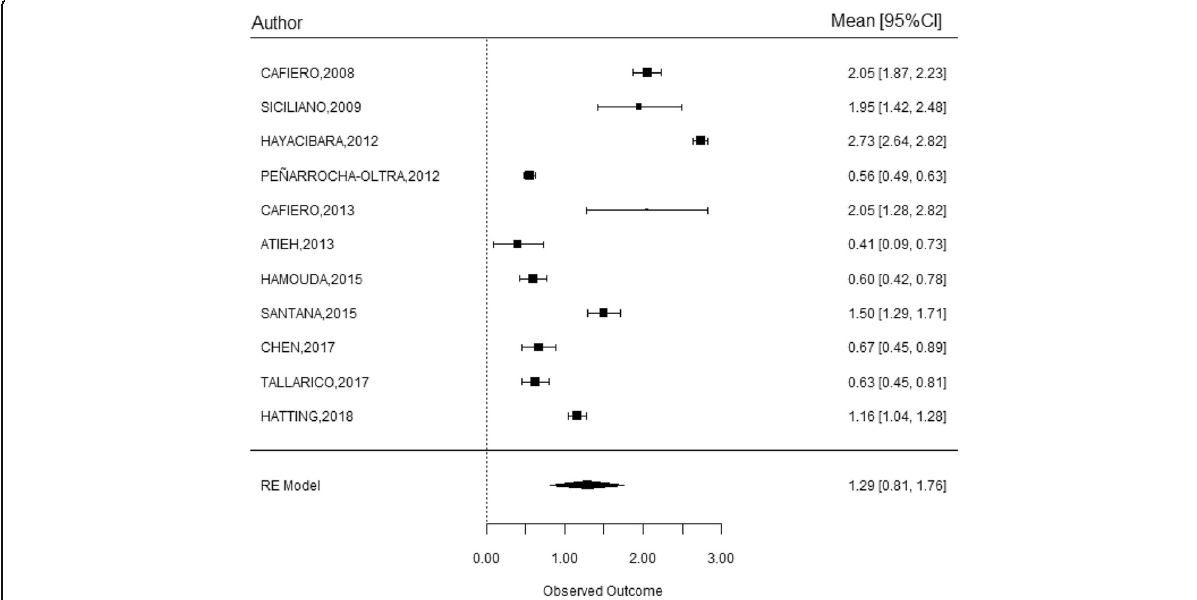
Fig. 4 Statistical analysis of marginal bone